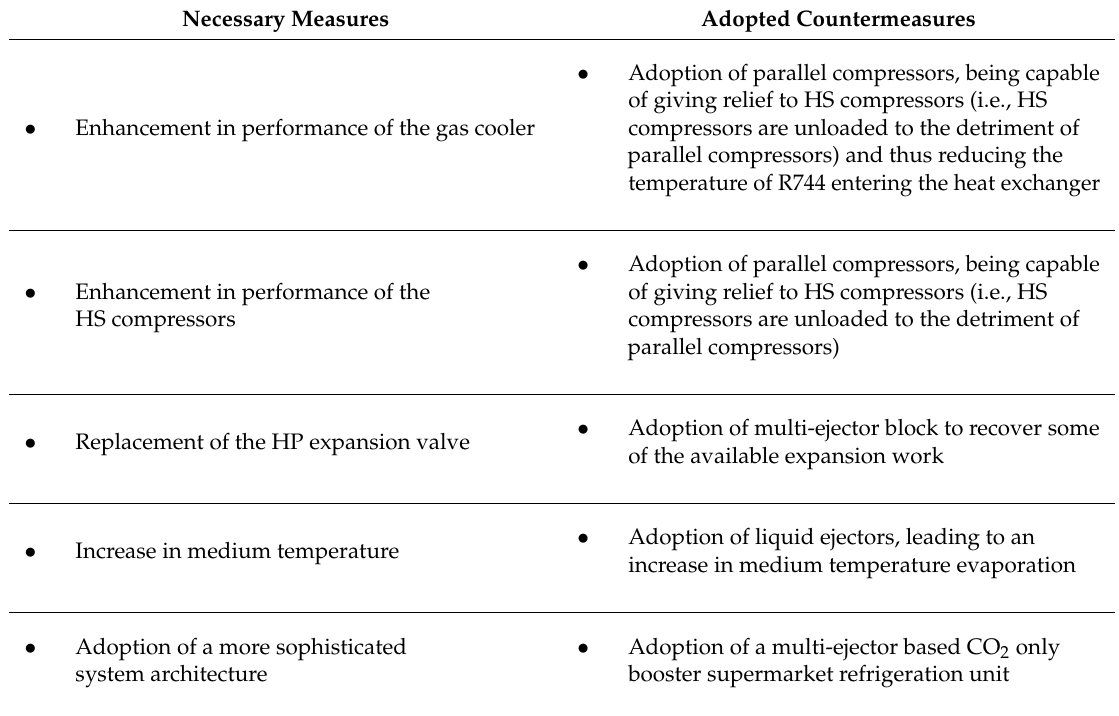
Table 10. Adopted countermeasures to implement the enhancement strategy presented in Section